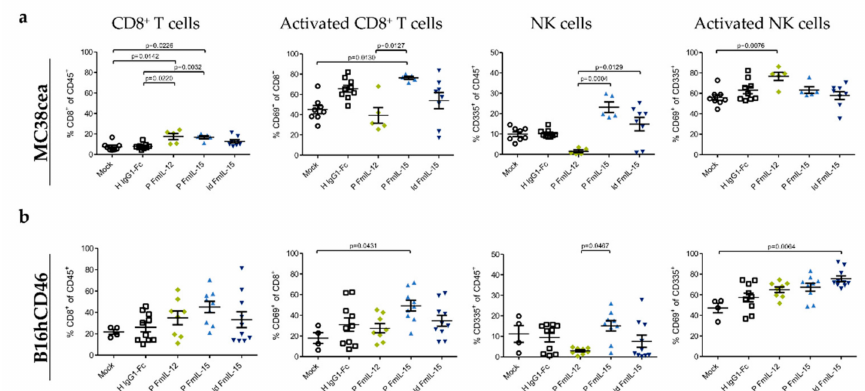
Figure 4. Tumor-infiltrating lymphocytes after MeVac treatment. MC38cea ( a ) or B16hCD46 ( b ) tumor cells were implanted subcutaneously in the right flank of C57BL / 6J mice. When tumors had reached a size of 50–100 mm 3 , mice received intratumoral injections of indicated MeVac variants on four consecutive days. Flow cytometry of tumor-infiltrating lymphocytes was performed one day after the fourth treatment. Symbols representing individual animals and the group mean with standard deviation are